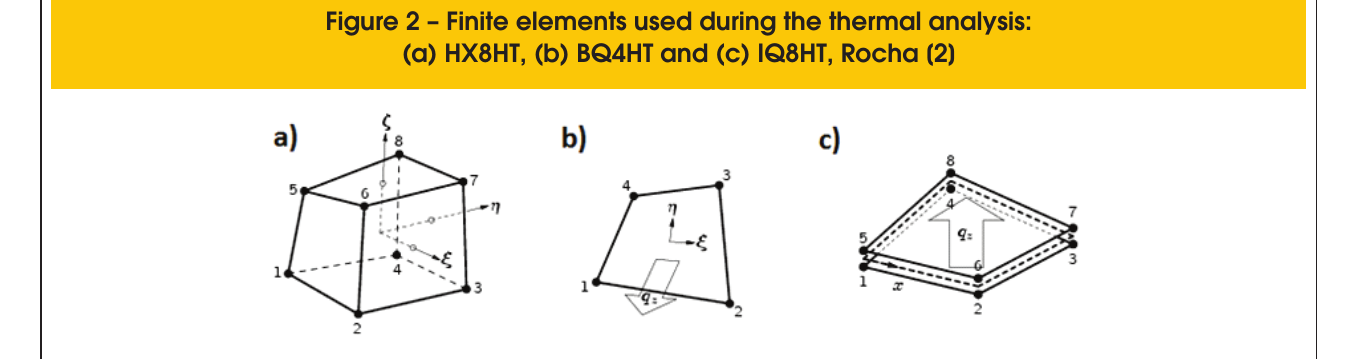
Figure 2 – Finite elements used during the thermal analysis: